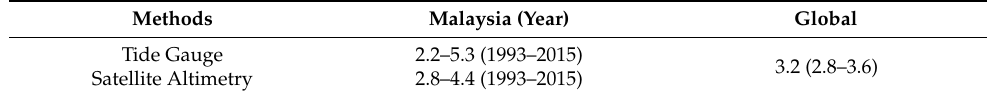
Table 3. Historical average rate of sea level (mm/year) based on IPCC AR5 [133]. Reproduced from Report on Impact of Climate Change: Sea Level Rise Projection in Malaysia, 2017; published by National Water Research Institute of Malaysia.